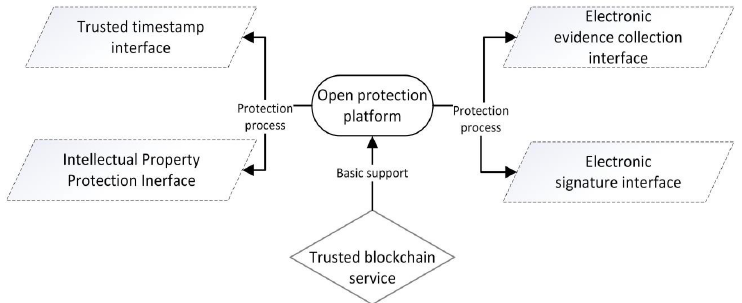
Fig. 3 The working mechanism of the music copyright protection